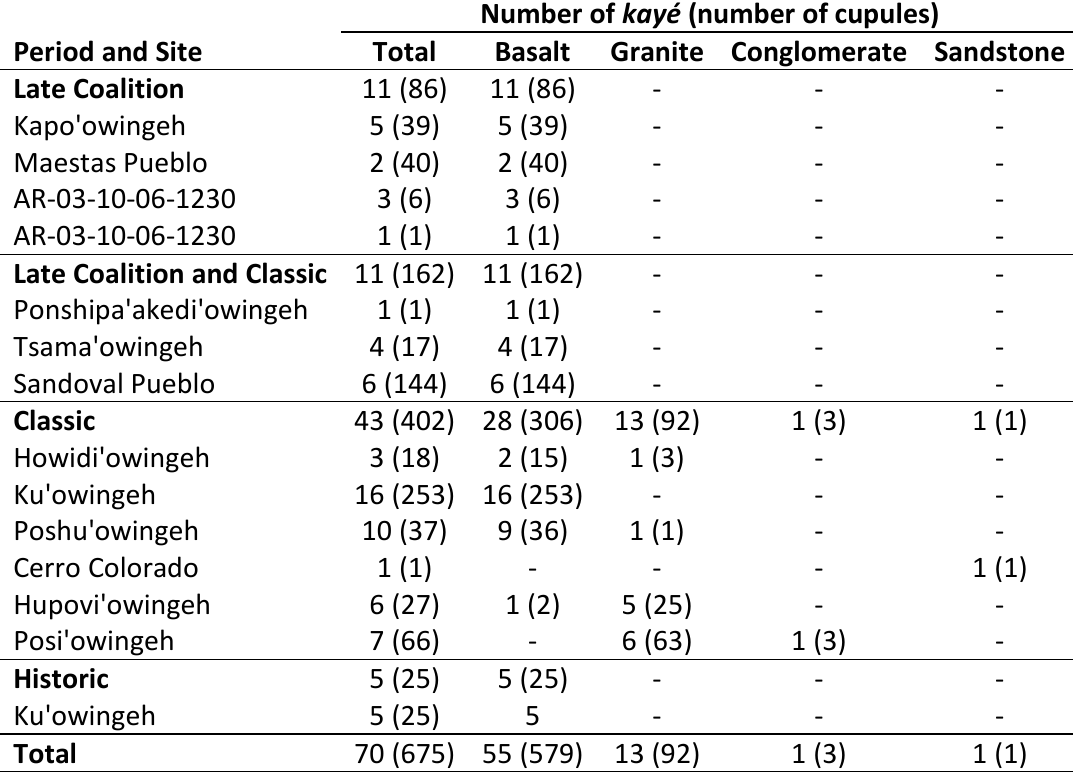
Table 2. Counts of kayé by site, period, and rock type.